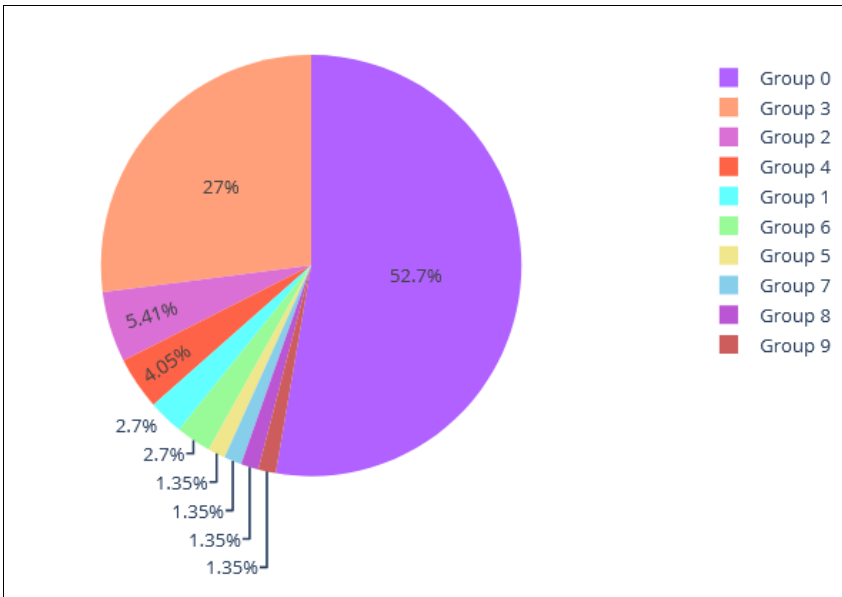
Figure 4. Pie chart of the example shown in Figure 3.